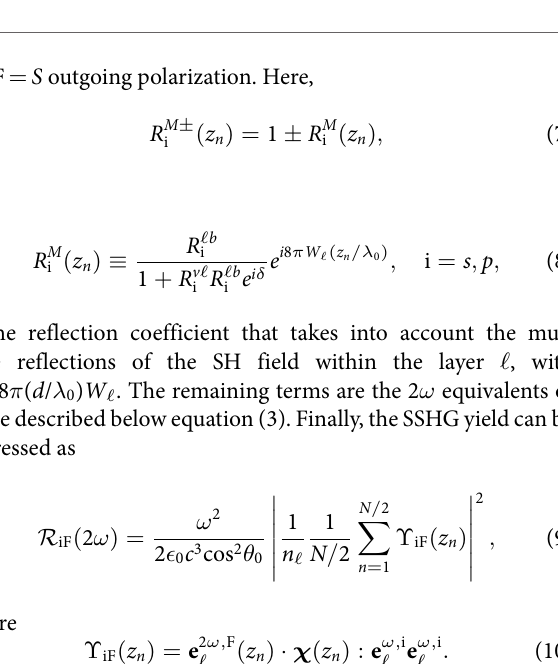
FIGURE 1 | Sketch of the three-layer model for SHG . The vacuum region ( v ) is on top with ϵ v = 1; the layer ℓ of thickness d is characterized by ϵ ℓ ( ω ), and it is where the SH polarization sheet P ℓ ( 2 ω ) is located at a distance z n . The bulk b is described by ϵ b ( ω ). The blue lines within the slab represent the SH multiple reflections. The Si(111)(1 (cid:2) 1):H surface used in this work is represented by the ball and stick model (H: small spheres, Si: large spheres) in the background. The red dotted line is the one of the many possible z n